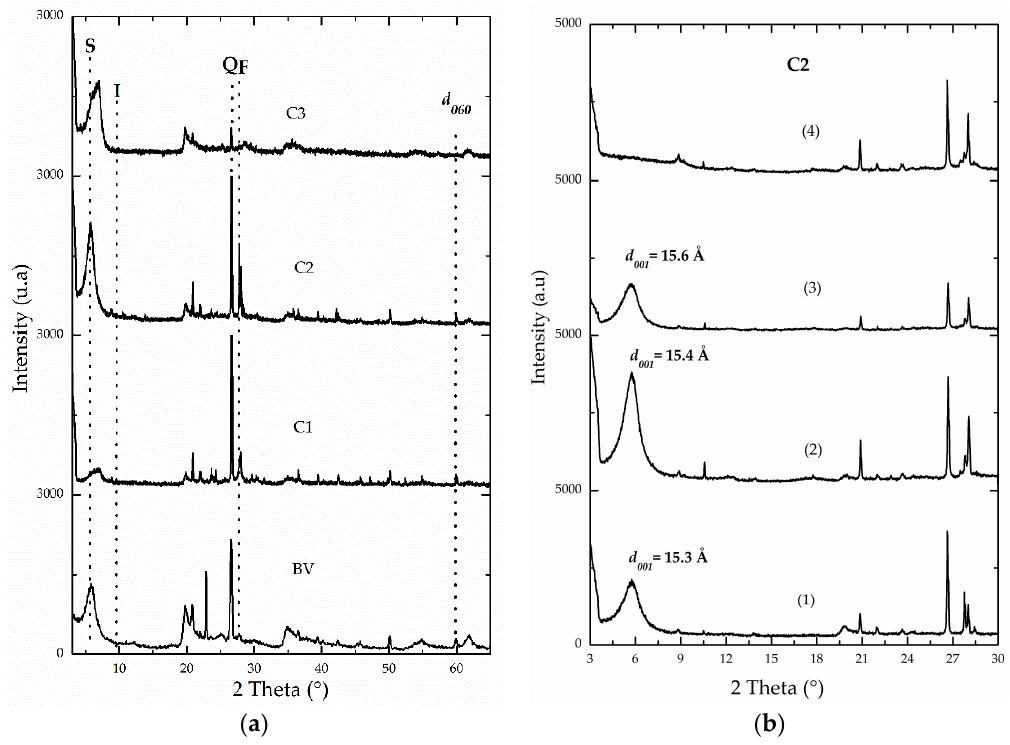
Figure 2. X-ray diffraction patterns of: ( a ) powders of untreated BV, C1, C2 and C3 raw minerals. (S: smectite, I: illite, Q: quartz, F: Feldspars); ( b ) oriented films of C2 clay under following